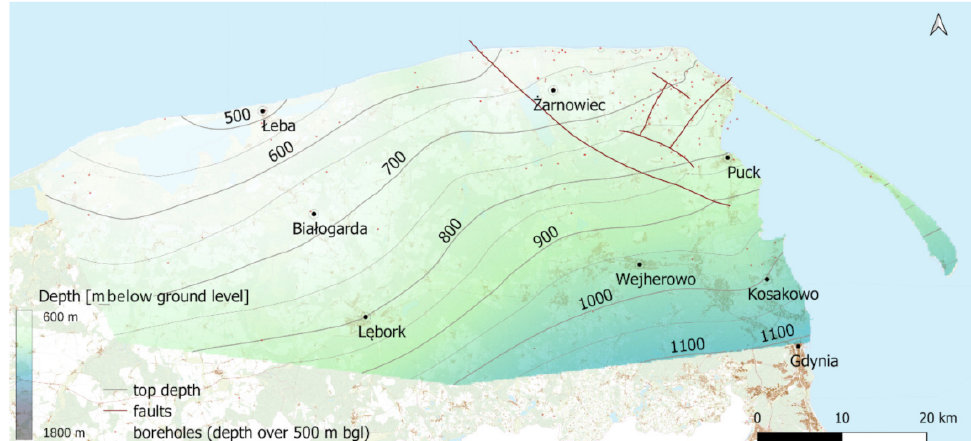
Figure A2. The top depth map of the oldest rock salt (Na1) layer based on the top depth raster.